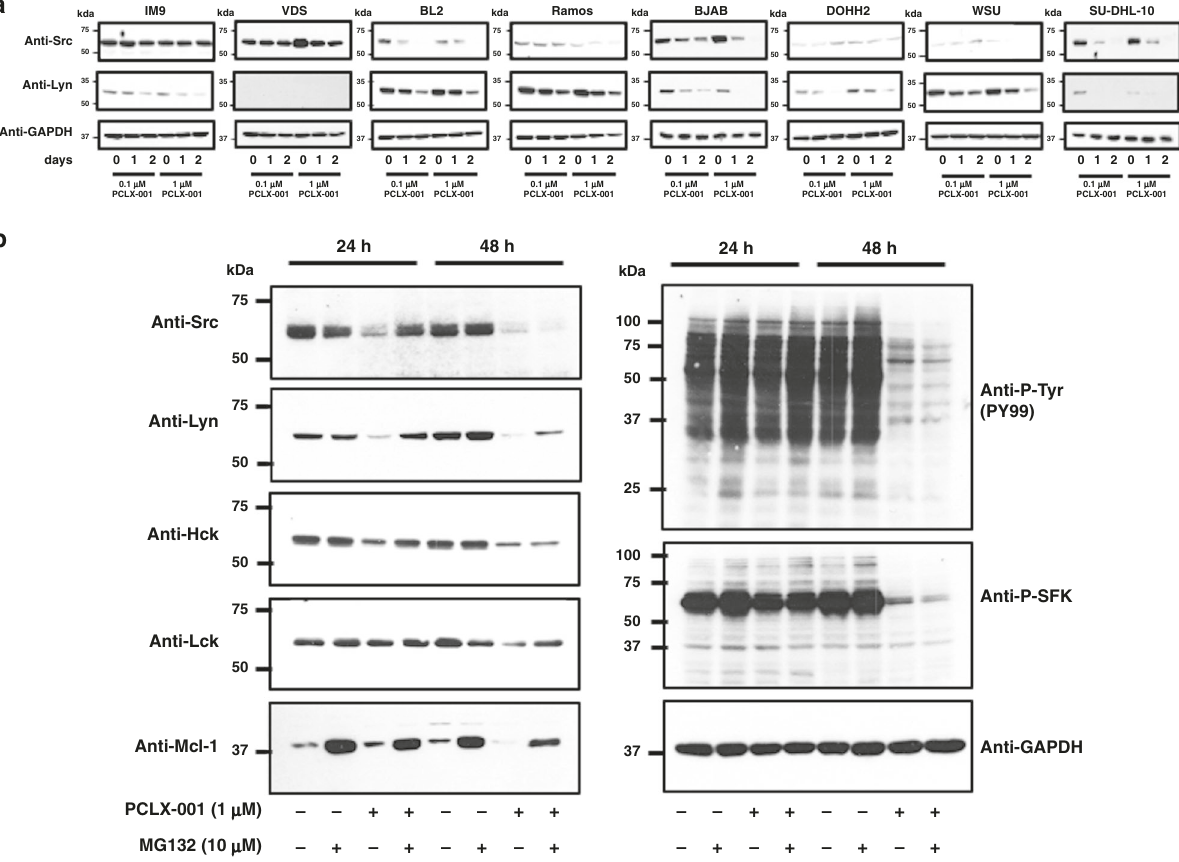
Fig. 3 PCLX-001 treatment results in SFK instability and degradation by the proteasome in lymphoma cell lines. Western blot for total Src and Lyn proteins in immortalized lymphocyte (IM9, VDS), BL (BL2, Ramos, BJAB), and DLBCL (DOHH2, WSU-DLCL2, SU-DHL-10) cell line lysates following 24 – 48 h of treatment with 0.1 µ M or 1.0 μ M PCLX-001 ( a ). After BCR ligation with anti-IgM, western blot for total Src, Lyn, Hck, Lck, Mcl-1, total phospho- tyrosine (PY99) and pan phosphorylated-SFK (P-SFK) protein levels in BL2 treated for 24 – 48 h with 1 µ M PCLX-001 in the presence or absence of 10 µ M of the proteasome inhibitor MG132 for the last 6 h ( b ). GAPDH serves as a loading control. All western blots shown are representative of three independent experiments. Source data are provided as a Source Data fi